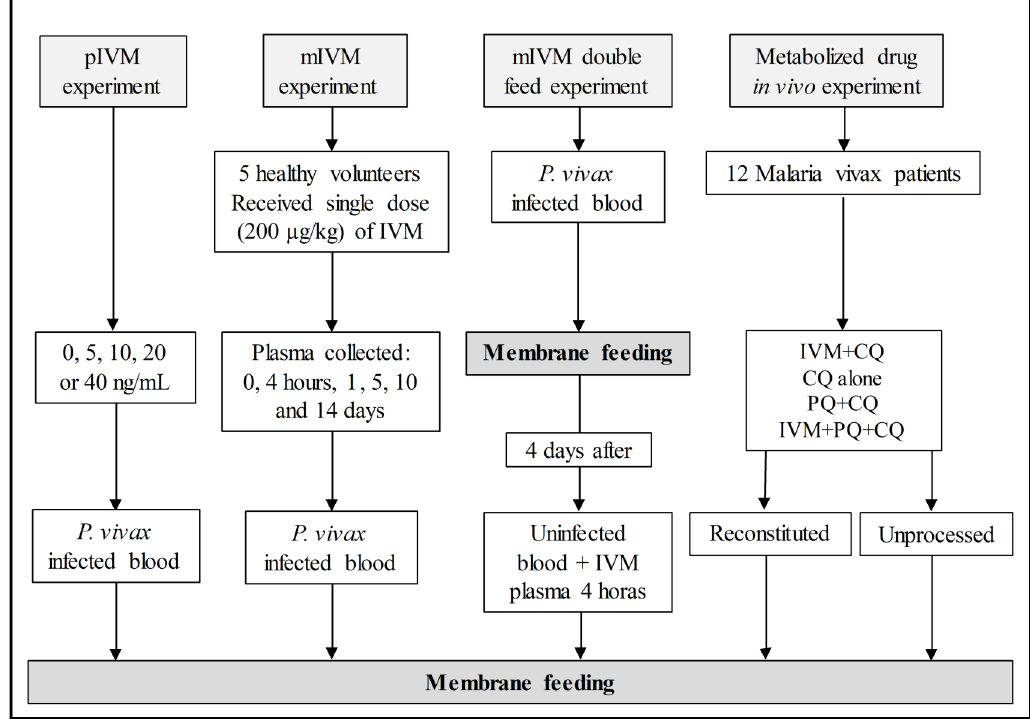
Fig 1. Schematic outline of the experiments of membrane feeding. Four experiments were performed to determine the transmission blocking potential of IVM in either An . aquasalis or An . darlingi . Abbreviations: Ivermectin (IVM), powdered ivermectin (pIVM), metabolized ivermectin (mIVM), chloroquine (CQ), primaquine